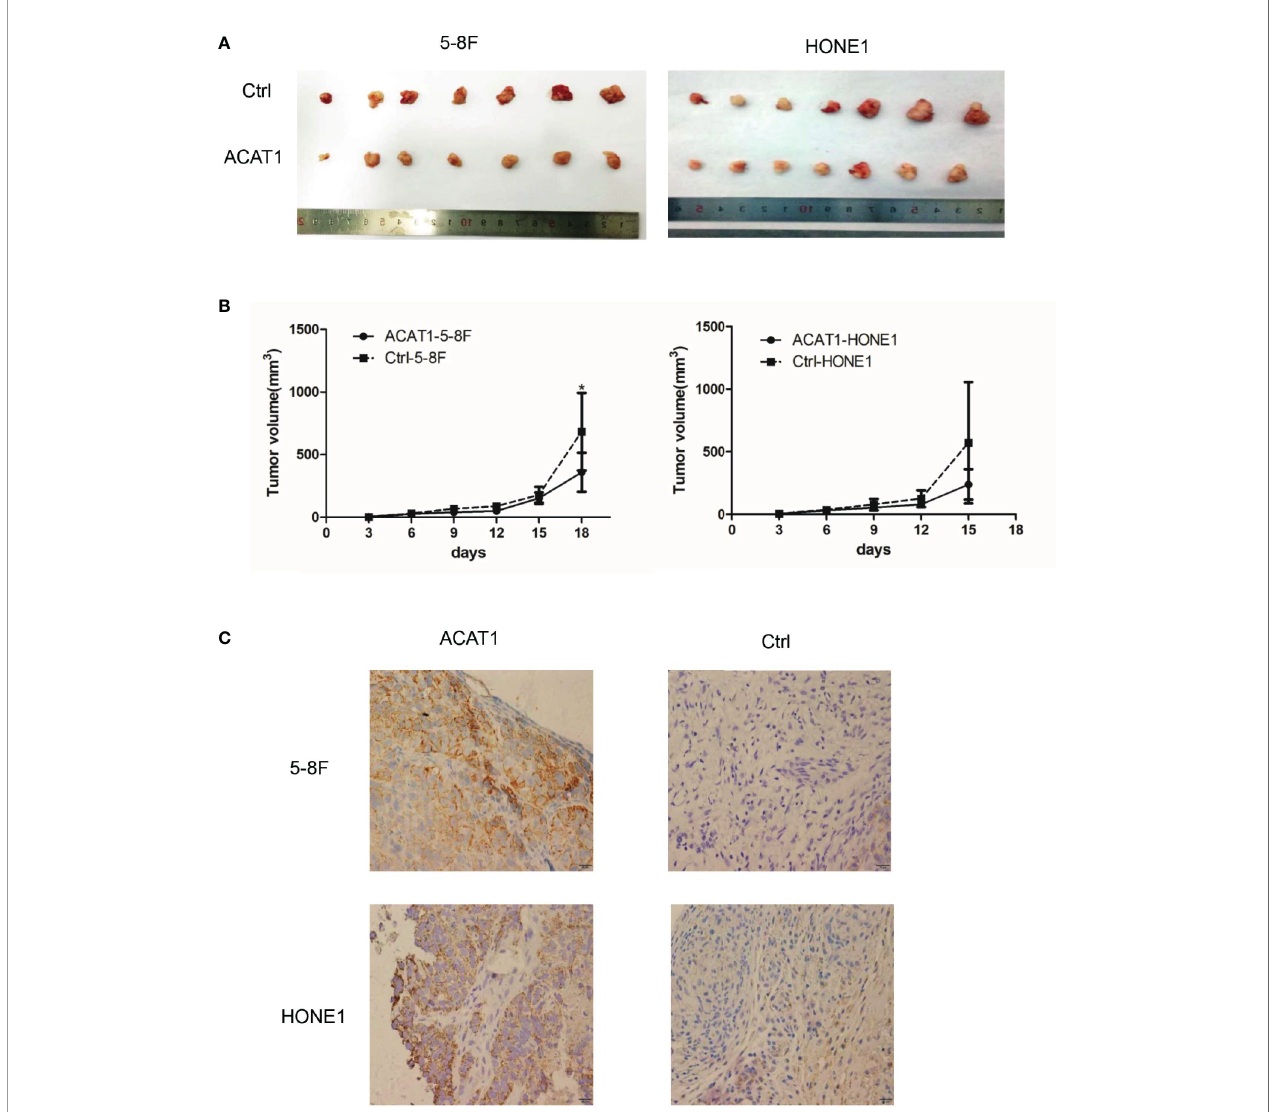
FIGURE 5 | ACAT1 suppresses tumorigenesis of NPC cells in vivo . (A) Xenografts in nude mice from inoculated ACAT1-5-8F/HONE1 and pCMV6-Entry-5-8F cells were removed at day 18 (5-8F) and day 15 (HONE1) (B) Volume of the tumors measured at 0, 3, 6, 9, 12, 15, 18 days after inoculation. (C) Immunohistochemistry staining was used to determine the expression of ACAT1 in xenografts. Magni fi cations ×400. The independent Student ’ s t-test was used to analyze the results and data are expressed as the means ± SD. * p <